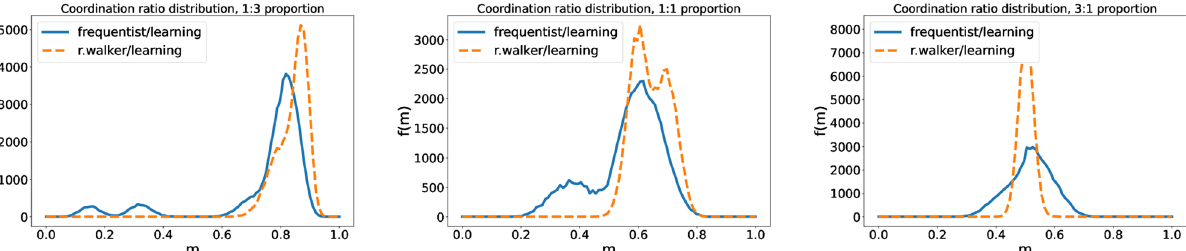
Figure 8. Coordination ratio for a a frequentist/learning or a random walker/learning agent population, with ratios (1:3) (left), (1:1) (middle), and (3:1)